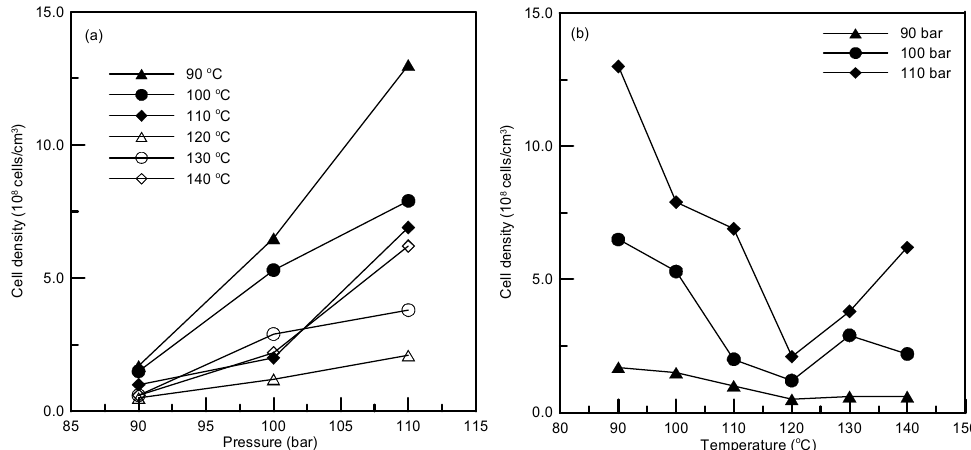
Figure 8. Effect of operating parameters on the cell size of microcellular foam of TPU: ( a ) effect of saturation pressure, ( b ) effect of saturation temperature.